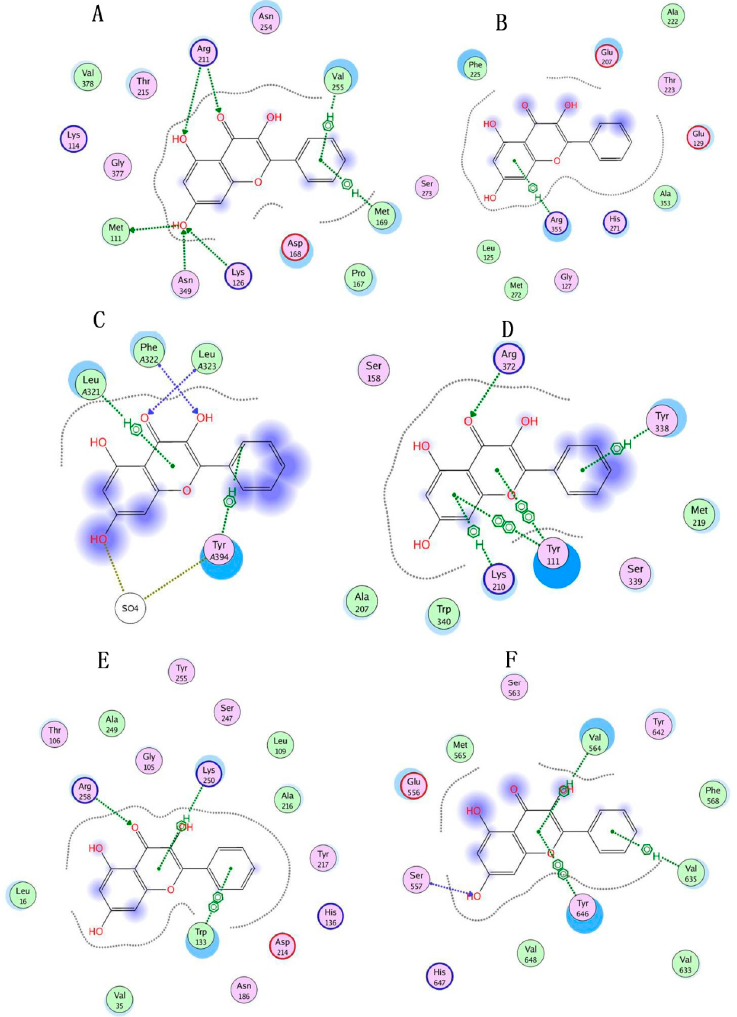
Figure 7. Molecular binding mode variation in the protein domains of galangin docking. ( A ) GLUD1; ( B ) GLUL; ( C ) GLS; ( D ) CTH; ( E ) GOT2; ( F ) HP.The different color rounds with different color ring outside stand for different character of the amino acid residue. The pink round with blue ring indicates that the amino acid residue is basic amino acid residue; the pink round with red ring stand for acidic one; the pink round with black ring infer that the amino acid residue is polar; the green round with black ring is greasy; and the blank round with black ring is metal complex. Arrow mark and green dotted line indicate hydrogen bonding and arene C-H bonding separately between galangin and protein domain residues. The blue shaded region indicates the solvent contacts made by galangin.